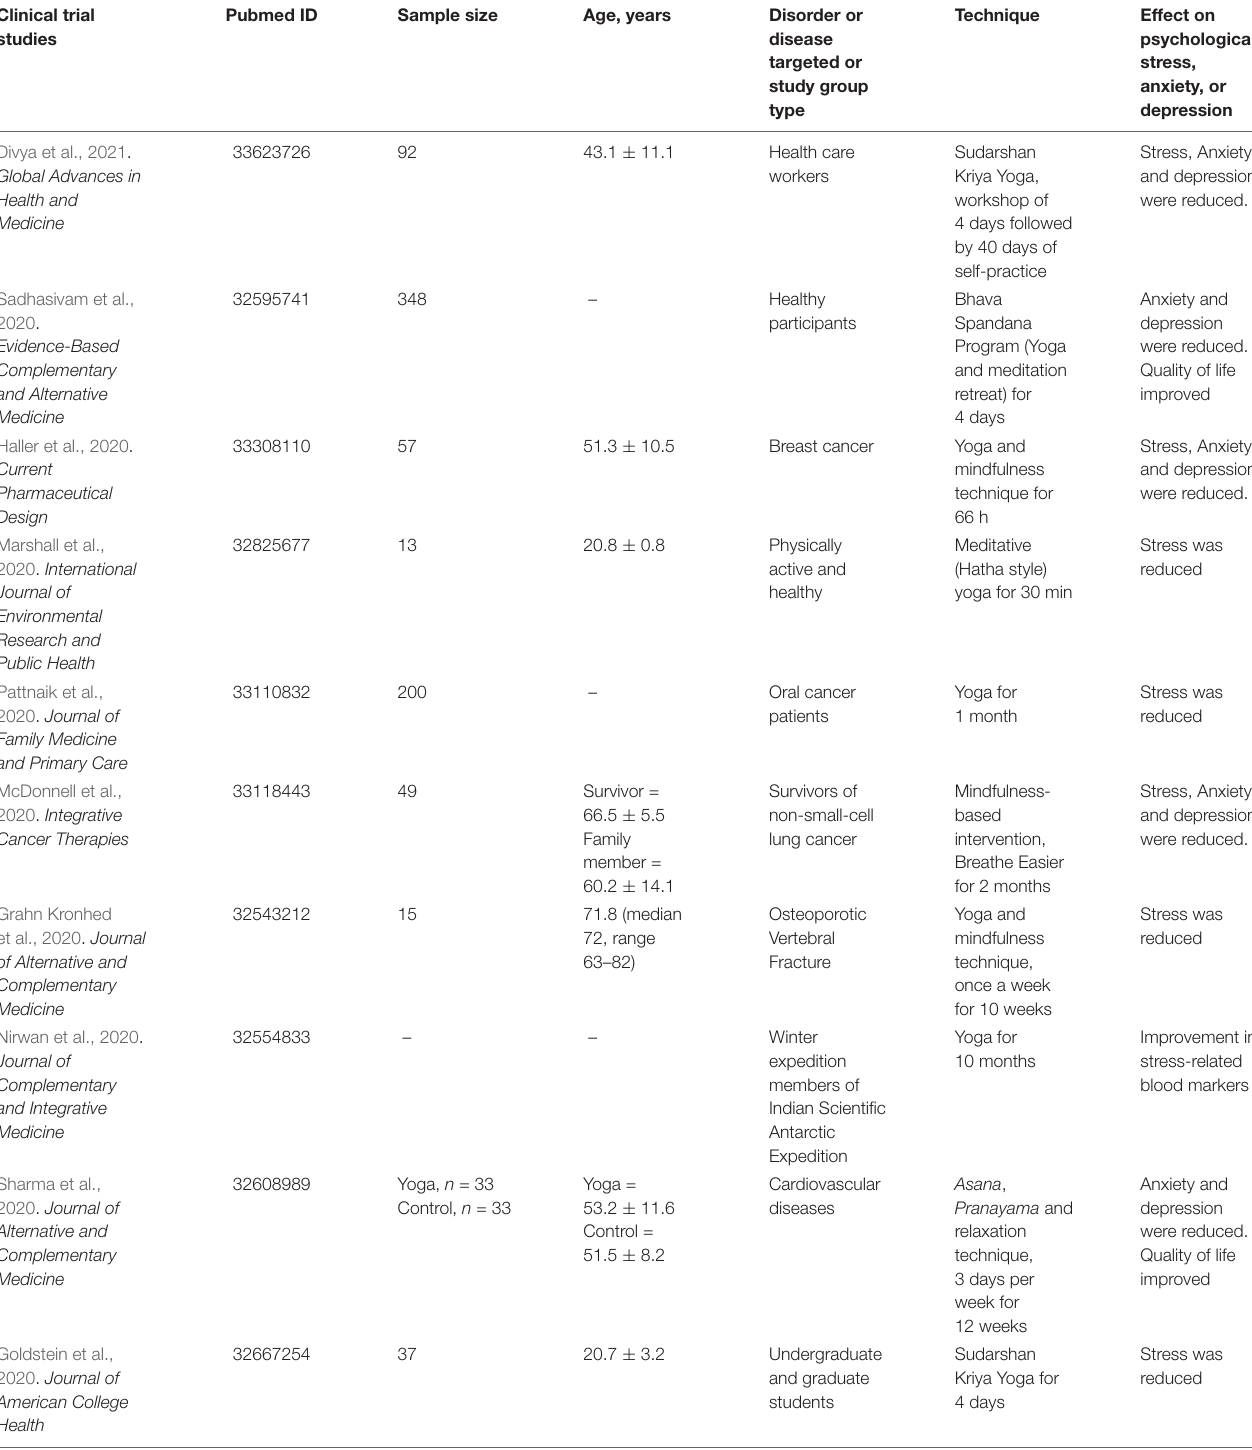
TABLE 1 | Stress and Anxiety reduction by Yoga and